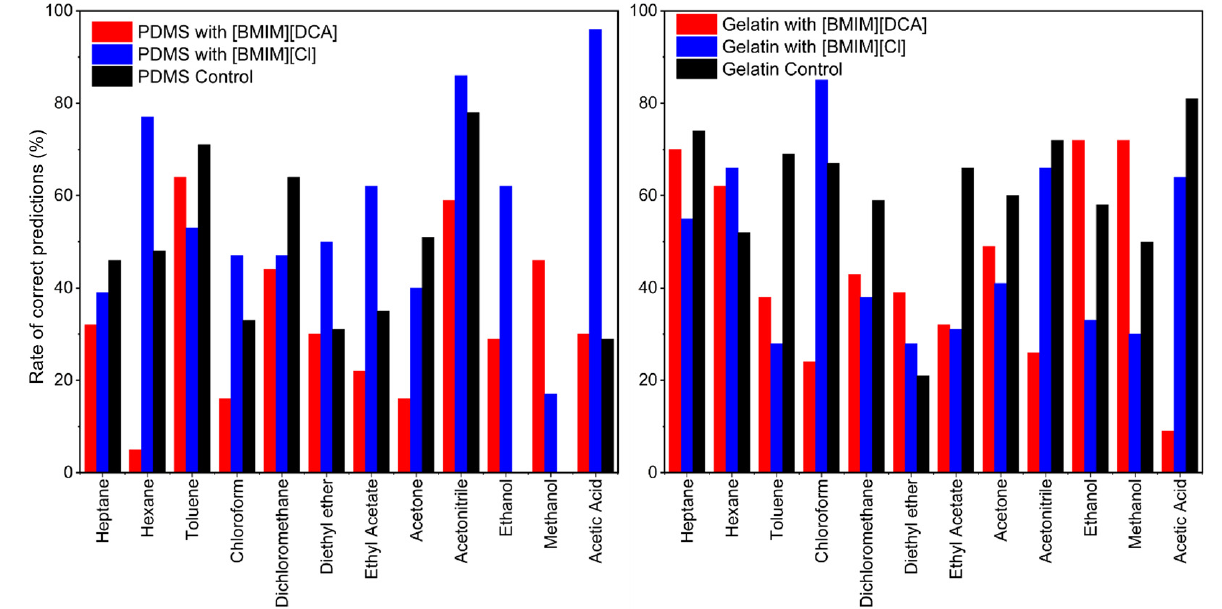
Figure 6. Average rates of correct prediction retrieved from the confusion matrices analysis regarding the ability of each sensor to predict each volatile being tested, during the optical e-nose experiments. A rate above 50% is considered a good classification performance of the volatile from the sensor. Sensors containing PDMS with [BMIM][DCA], [BMIM][Cl] and without ionic liquid (control), as well as sensors containing gelatin with [BMIM][DCA], [BMIM][Cl] and without ionic liquid (control) are represented.